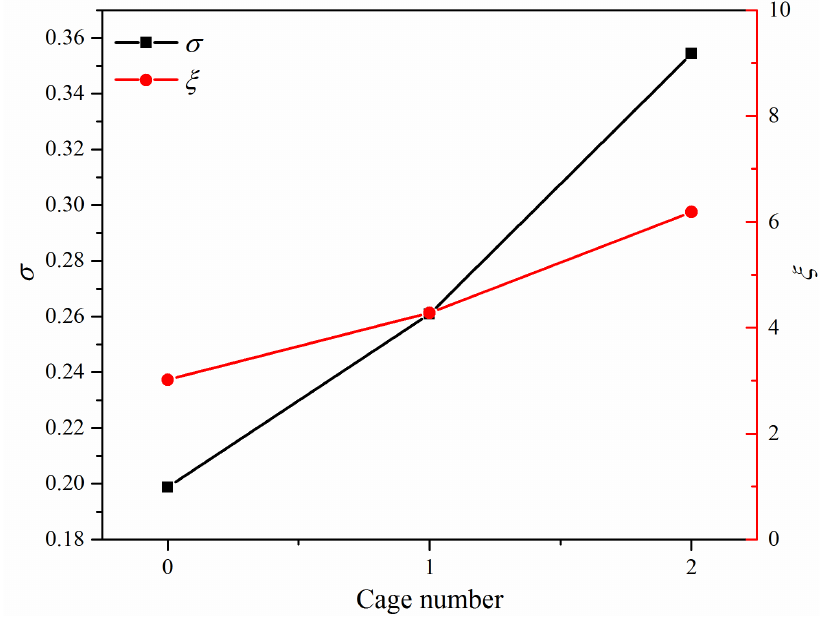
Figure 6. Comparison of cavitation number and loss coefficient for the globe valve with a different number of cages.